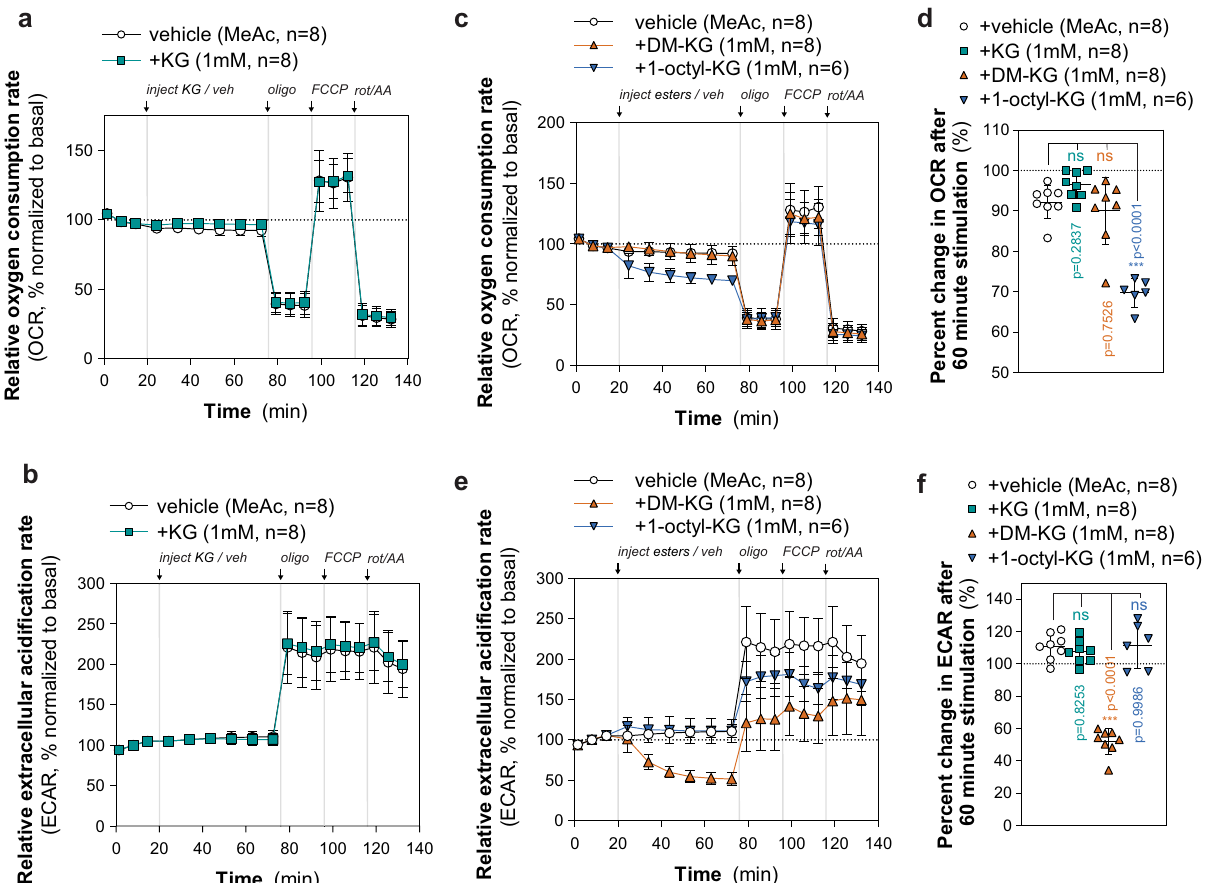
Fig. 3 Esteri fi ed KG analogs exhibit KG-independent effects on glycolytic and mitochondrial metabolism. a , b Relative oxygen consumption rate (OCR, a ) and extracellular acidi fi cation rate (ECAR, b ) of 8988T cells upon stimulation with 1 mM of KG or methyl acetate after the establishment of baseline OCR for ~20 m (basal). Following 60-m stimulation, sequential injections of oligomycin (oligo), FCCP, and rotenone with antimycin A (rot/AA) were made. Data are mean ± s.d. of n = 8 biologically independent experiments. Data were normalized to the average of the three basal OCR and ECAR values from each experiment. c Relative OCR of 8988T cells upon stimulation with methyl acetate or 1 mM of DMKG or 1-octyl-KG. Data are mean ± s.d. of n = 6 (1- octyl-KG) or n = 8 (methyl acetate, DMKG) biologically independent experiments. d Percent change in OCR of 8988T cells stimulated with methyl acetate or 1 mM of KG, DMKG, or 1-octyl-KG for 60 m. Data are plotted as a percent relative to baseline OCR for each biologically independent experiment prior to stimulation. Data are mean ± s.d. of n = 6 (1-octyl-KG) or n = 8 (methyl acetate, DMKG) biologically independent experiments; signi fi cance determined by one-way ANOVA using Dunnett ’ s multiple comparisons test, n.s. p > 0.05, *** p < 0.0001. e Relative ECAR of 8988T cells upon stimulation with methyl acetate or 1 mM of DMKG or 1-octyl-KG. Data are mean ± s.d. of n = 6 (1-octyl-KG) or n = 8 (methyl acetate, DMKG) biologically independent experiments. f Percent change in ECAR of 8988T cells stimulated with methyl acetate or 1 mM of KG, DMKG, or 1-octyl-KG for 60 m. Data are plotted as a percent relative to baseline ECAR for each biologically independent experiment prior to stimulation. Data are mean ± s.d. of n = 6 (1-octyl-KG) or n = 8 (methyl acetate, DMKG) biologically independent experiments; signi fi cance determined by one-way ANOVA using Dunnett ’ s multiple comparisons test, n.s. p > 0.05, *** p <